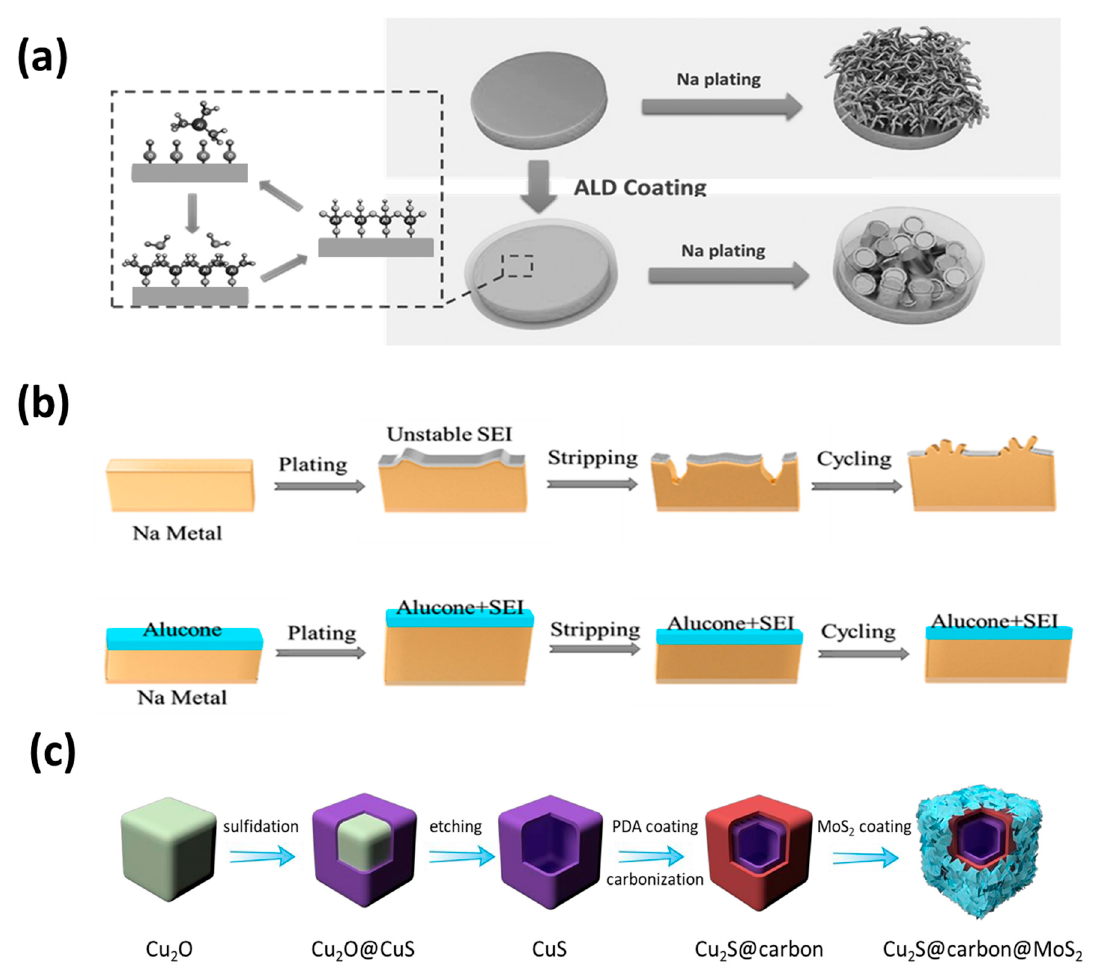
Figure 7. Schematic diagram of Na stripping-plating on bare Na foil and Na foil with ( a ) atomic layer deposition (ALD) coatingand ( b ) molecular layer deposition (MLD) Alucone coating (Alucone: New aluminum-based organic-inorganic composite film). ( c ) Schematic diagram of Na stripping/plating on bare Na foil and Na foil with MLD Alucone coating.